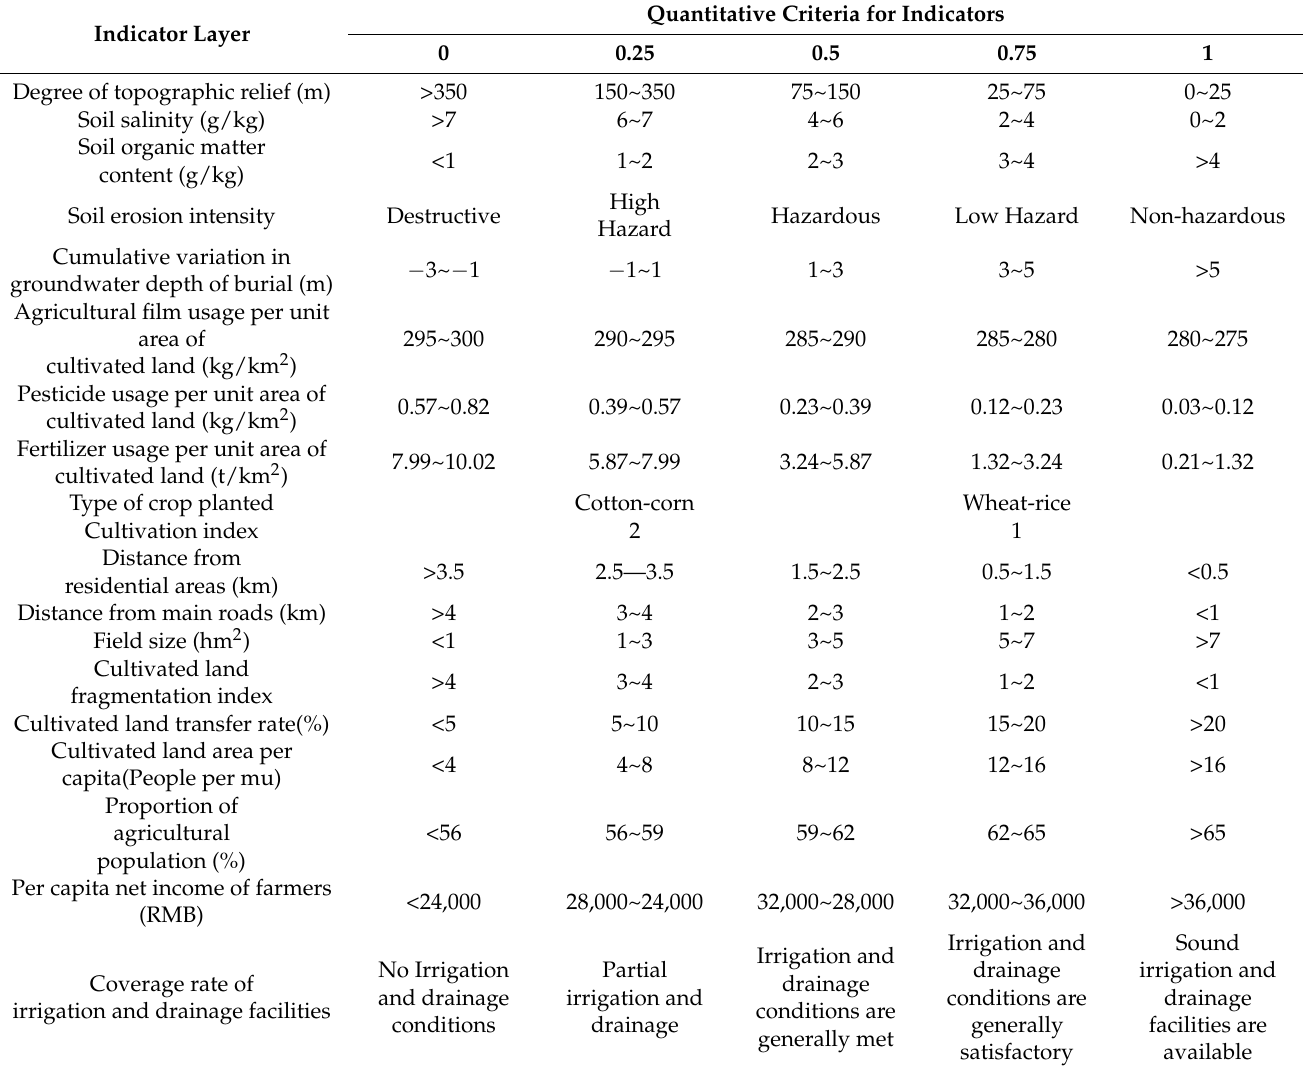
Table 2. Standardization of evaluation